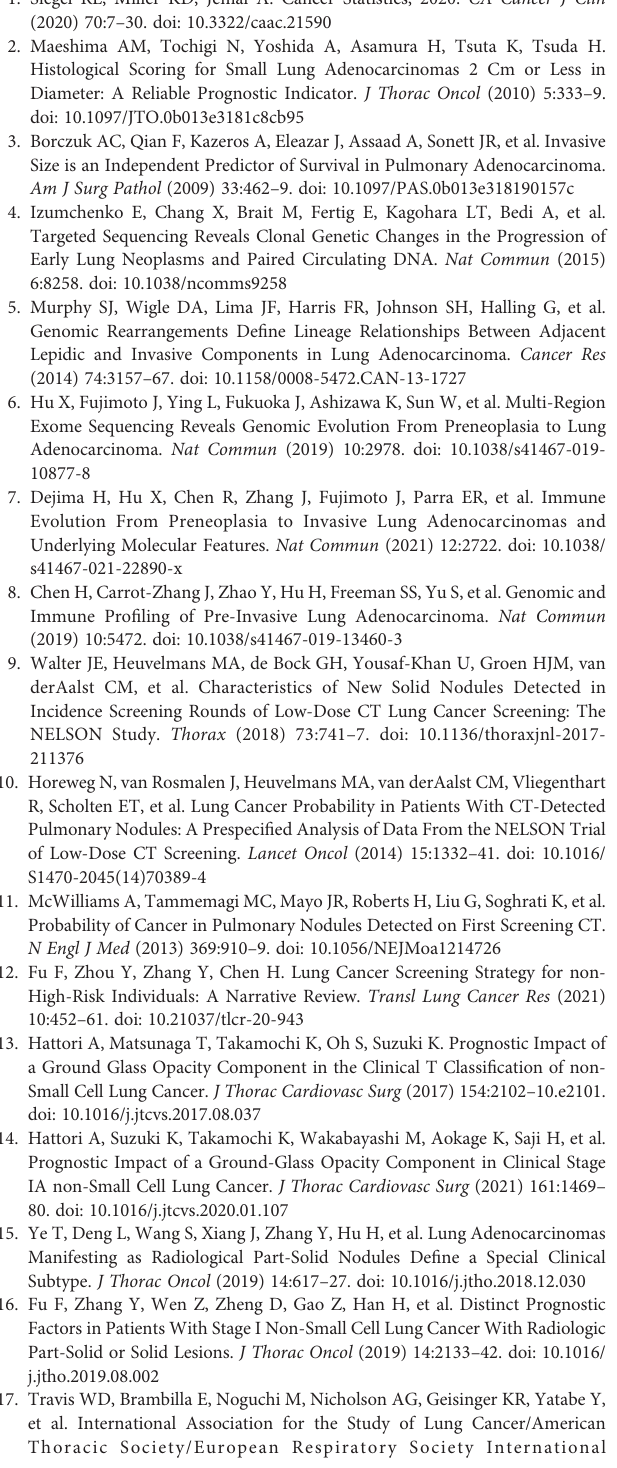
Supplementary Figure 3 | Prediction of number of (A) CD8+ T cells, (B) Tregs, and (C) natural killer (NK) cells for different tumor